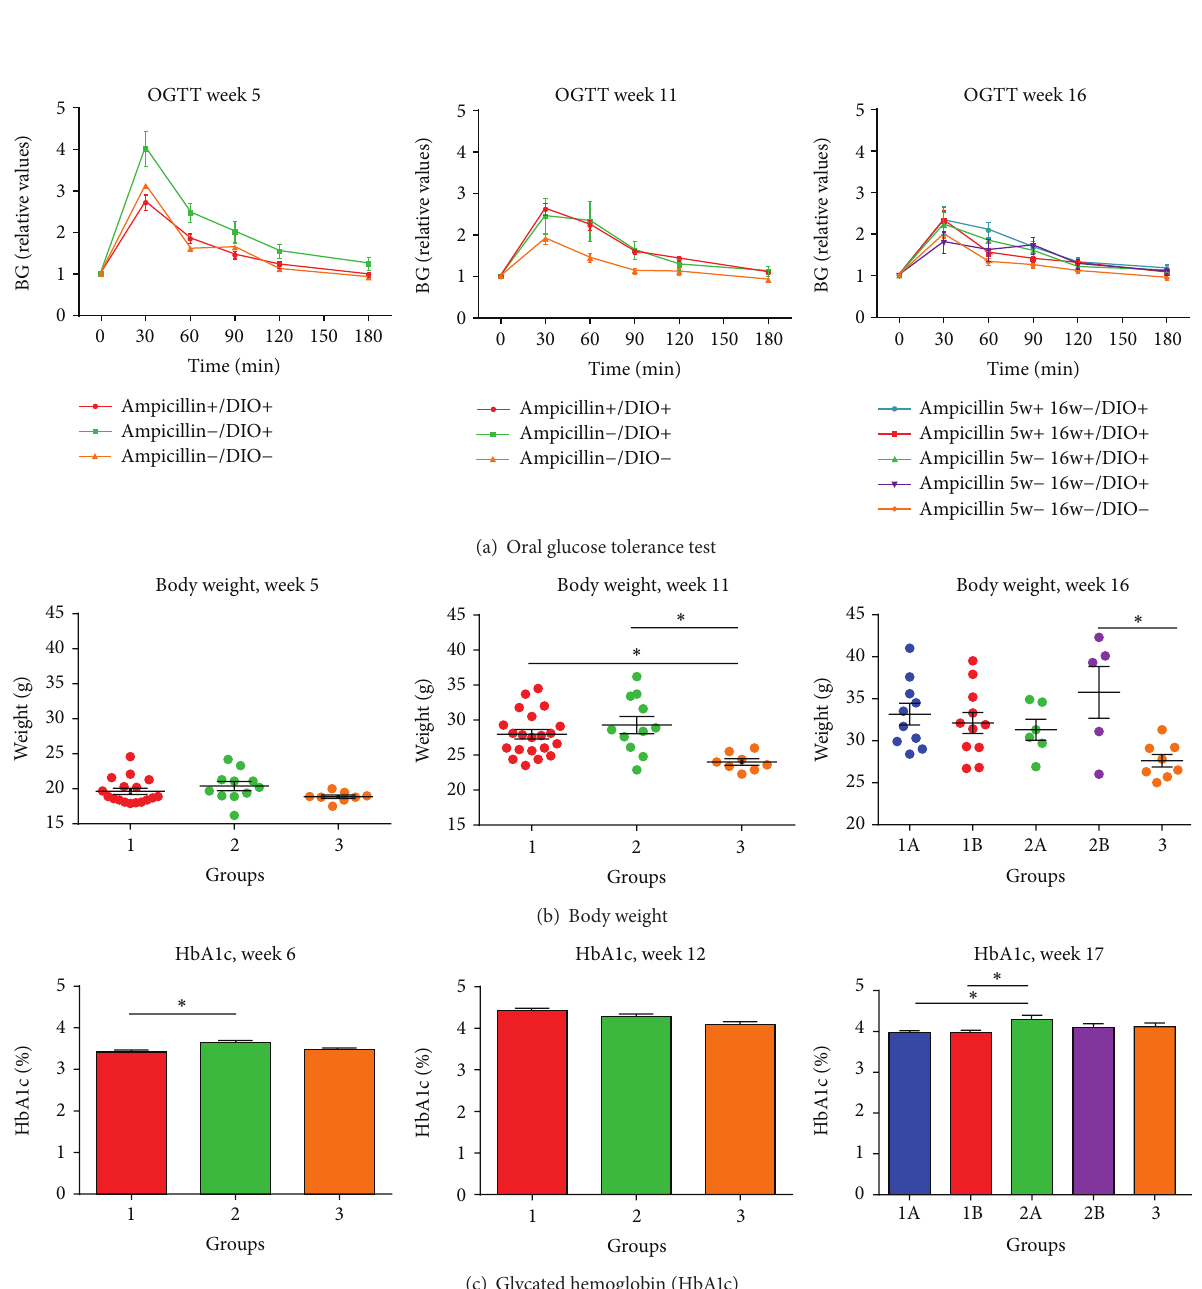
Figure 2: (a) Oral glucose tolerance (mean and SEM, relative values). Statistics were calculated on areas under the curves (AUC) and showed statistically significant differences between groups 1 (Ampicillin+/DIO+) and 2 (Ampicillin − /DIO+) at five weeks of age ( 𝑃 = 0.0067 ). At 11 weeks of age, no difference between the high-fat fed groups could be demonstrated, but differences between groups 1 (Ampicillin+/DIO+) and 3 (Ampicillin − /DIO − ) were now evident ( 𝑃 = 0.04 ). At 16 weeks of age, differences between the early Ampicillin-treated group 1A (Ampicillin 5w+ 16w − /DIO+) and the low-fat fed group 3 (Ampicillin 5w − 16w − /DIO − ) were still evident ( 𝑃 = 0.028 ). (b) At five weeks of age, no difference between body weights could be demonstrated, whereas differences between the high-fat fed groups 1 (Ampicillin+/DIO+) and 2 (Ampicillin − /DIO+) compared to the low-fat fed group 3 (Ampicillin − /DIO − ) were evident at 11 weeks of age ( 𝑃 = 0.0028 ). At 16 weeks of age, only a difference between the nontreated high-fat fed group 2B (Ampicillin 5w − 16w − /DIO+) and low-fat fed group 3 (Ampicillin 5w- 16w − /DIO − ) could be demonstrated ( 𝑃 = 0.0159 ) (mean and SEM depicted). (c) Glycated hemoglobin (% HbA1c, mean and SEM) shows differences between the high-fat fed groups 1 (Ampicillin+/DIO+) and 2 (Ampicillin − /DIO+) at six weeks of age ( 𝑃 = 0.037 ), whereas now difference could be demonstrated at 12 weeks of age. At 17 weeks of age, differences were found between the early treated groups 1A(Ampicillin 5w+ 16w − /DIO+) and 1B (Ampicillin 5w+ 16w+/DIO+) and the late treated group 2A (Ampicillin 5w − 16w+/DIO+), respectively ( 𝑃 = 0.036 ; 𝑃 = 0.029